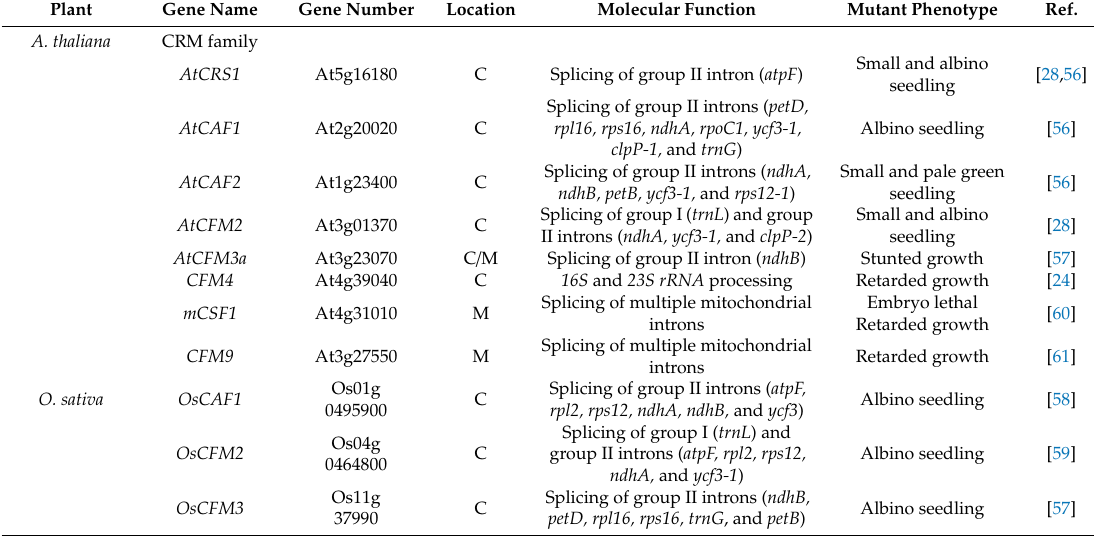
Table 1. Phenotypes and functions of CRM, PPR, DBRH, and SDP proteins in plant growth and